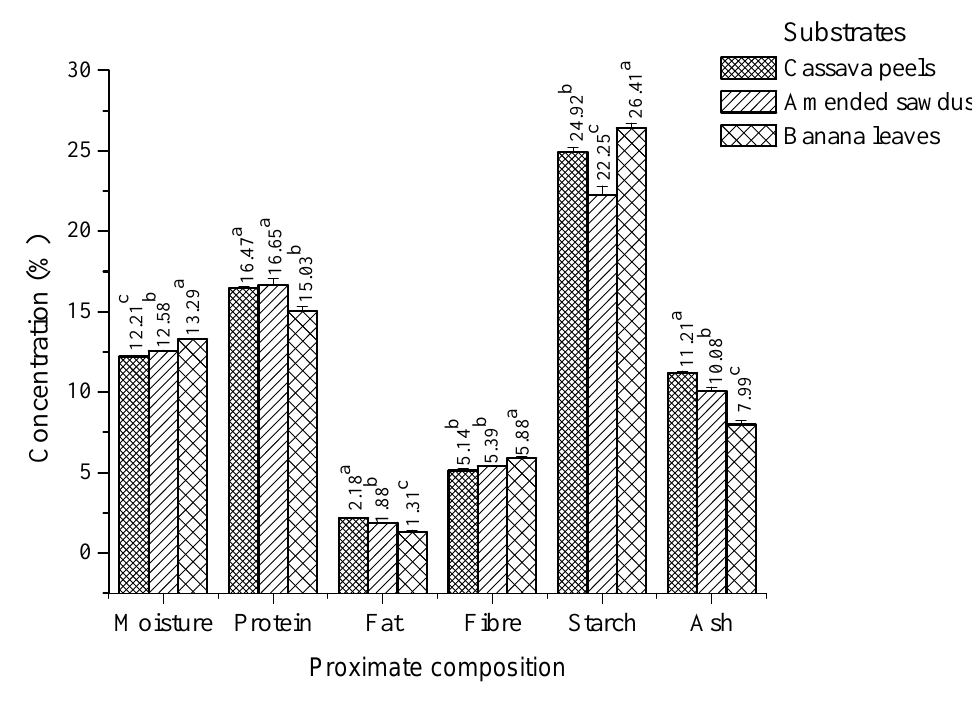
Figure 2: Proximate analysis of Pleurotus ostreatus as influenced by substrates. Effects of substrates on minerals in